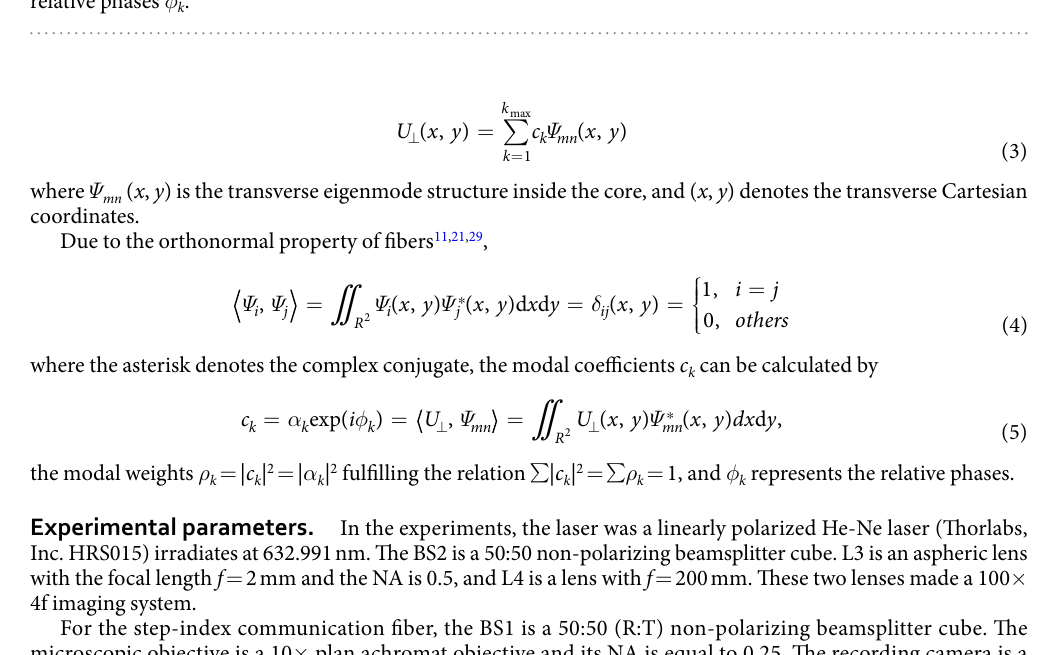
Figure 5. The modal coefficients of the LMA fiber. ( A1 , B1 and C1 ) The modal weights ρ k . ( A2 , B2 and C2 ) The relative phases φ k